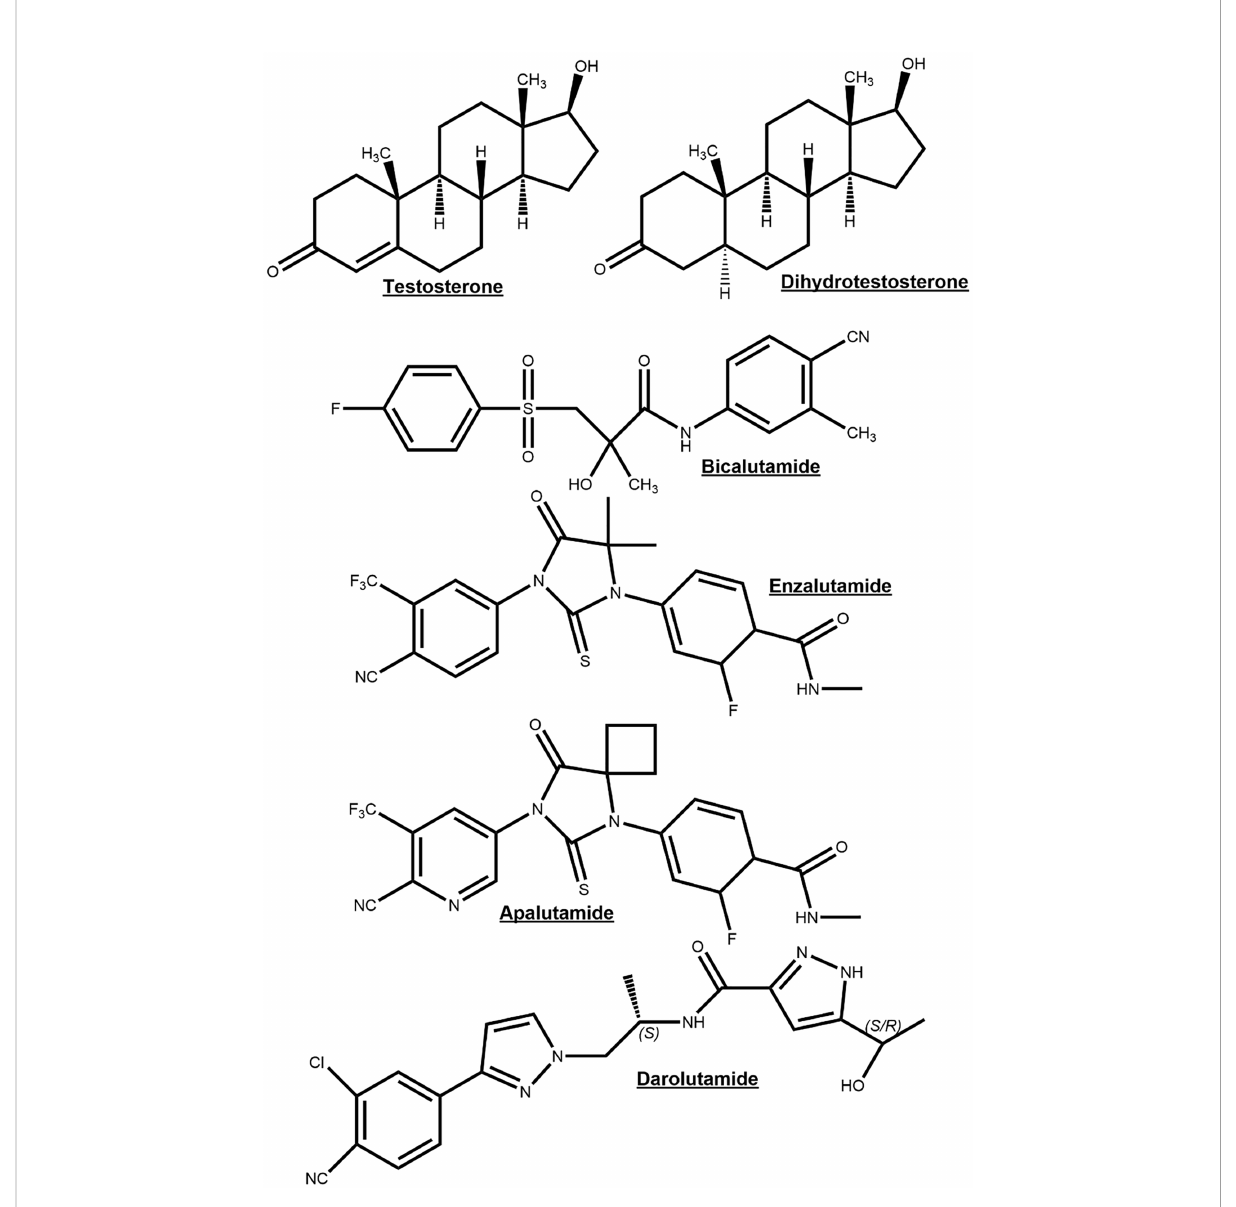
FIGURE 4 Chemical structures of the endogenous androgen receptor (AR) agonists testosterone and dihydrotestosterone for comparison to AR- antagonists bicalutamide, enzalutamide, apalutamide and